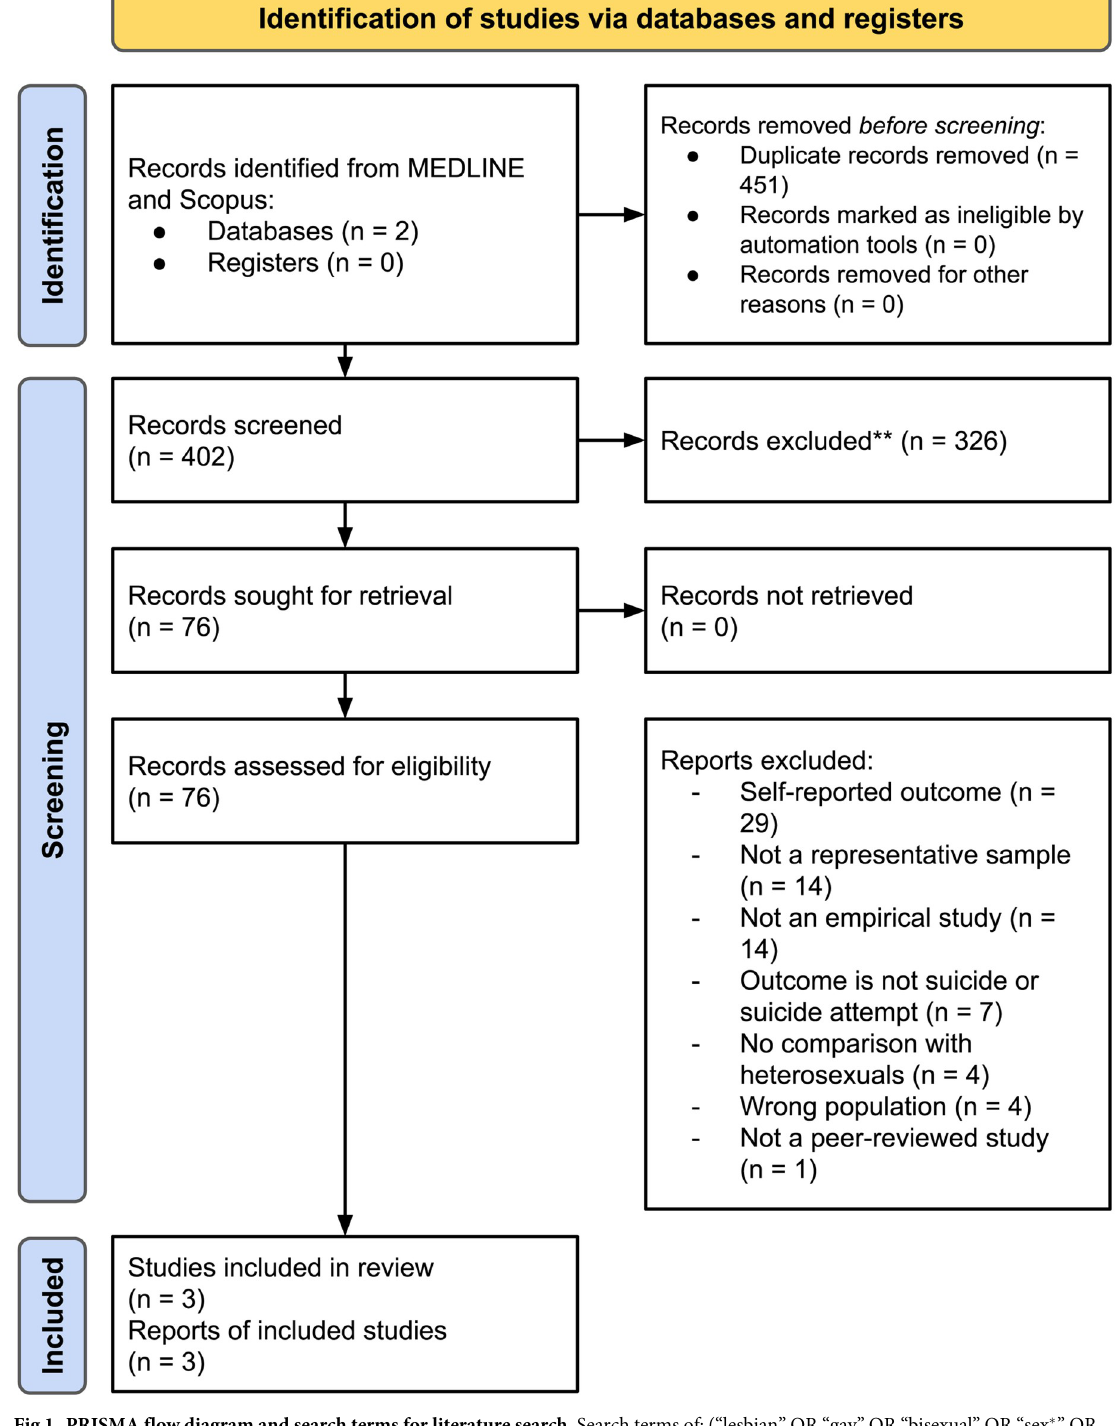
Fig 1. PRISMA flow diagram and search terms for literature search. Search terms of: (“lesbian” OR “gay” OR “bisexual” OR “sex � ” OR “minorit � ” OR “orientation” OR “homosexual” OR “sex � identity”) AND (“suicid � ” OR “self?harm”) AND (“administrative” OR “medical? records” OR “hospital-based” OR “clinical” OR “emergency” OR “ED” OR “acute care”) for the period January 1995 to December 2021.